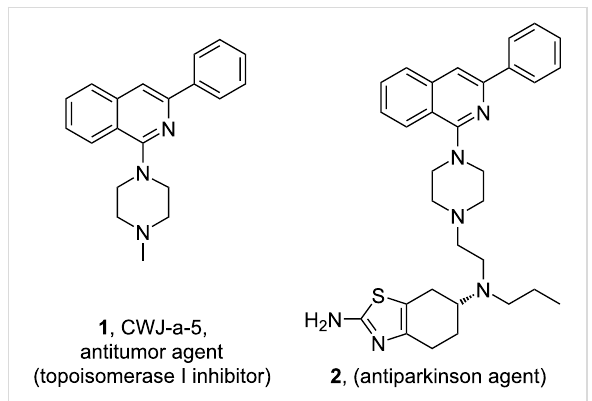
Figure 1: Biologically active